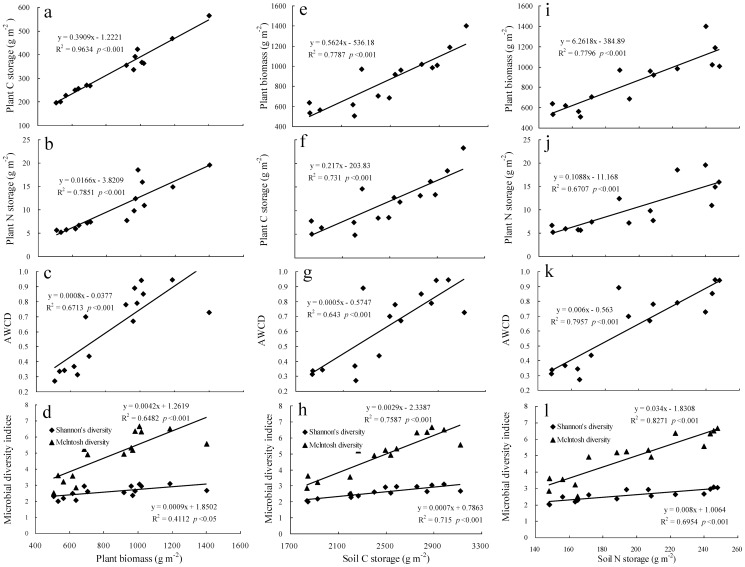
The relationships of plant biomass with plant C/N storage (a/b), AWCD (c) and soil microbial diversity indices (d), and the relationships of soil C/N storage with plant biomass (e/i), plant C/N storage (f/j), AWCD (g/k) and soil microbial diversity indices (h/l) across the three treatments in July, 2012.